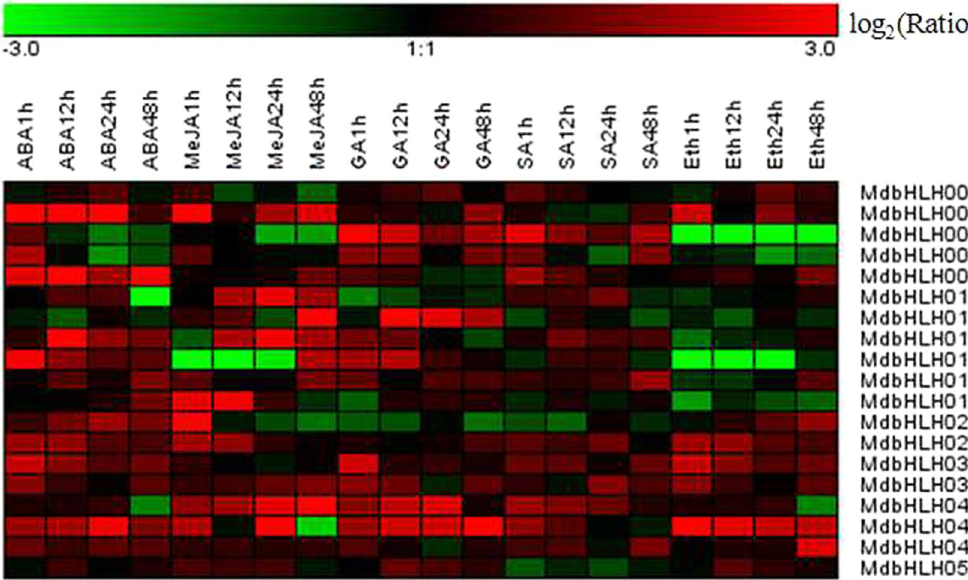
Figure 8. Expression profiles of 19 MdbHLH genes in response to various hormones. The results of the quantitative RT-PCR were analyzed using Gene Tools software, and the relative expression levels of MdbHLH genes under the various treatments compared to the controls were used for hierarchical cluster analysis using MeV 4.8.1. The color scale represents relative expression levels, with red indicating increased transcript abundance and green indicating decreased transcript abundance. The following five hormone treatments were tested: abscisic acid (ABA), methyl jasmonic acid (MeJA), salicylic acid (SA), gibberellin (GAs), and ethylene